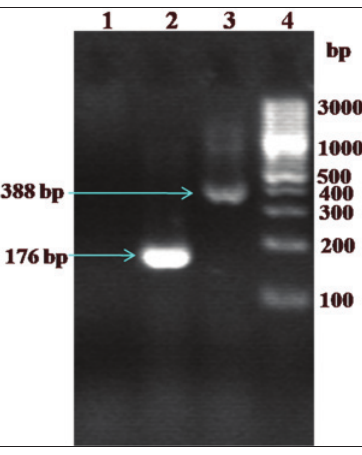
Figure-1: Polymerase chain reaction (PCR) amplification of U3 gene fragment of Jaagsiekte resolved on 2.0% agarose gel electrophoresis: Lane 1 - Non-template PCR control; Lane 2 - Amplification of JAG U3 gene; Lane 3 - Negative control (with healthy sheep lungs DNA and glyceraldehyde- 3-phosphate dehydrogenase primers) and Lane 4: 100 bp plus DNA ladder (Fermentas, Cat SM0323).